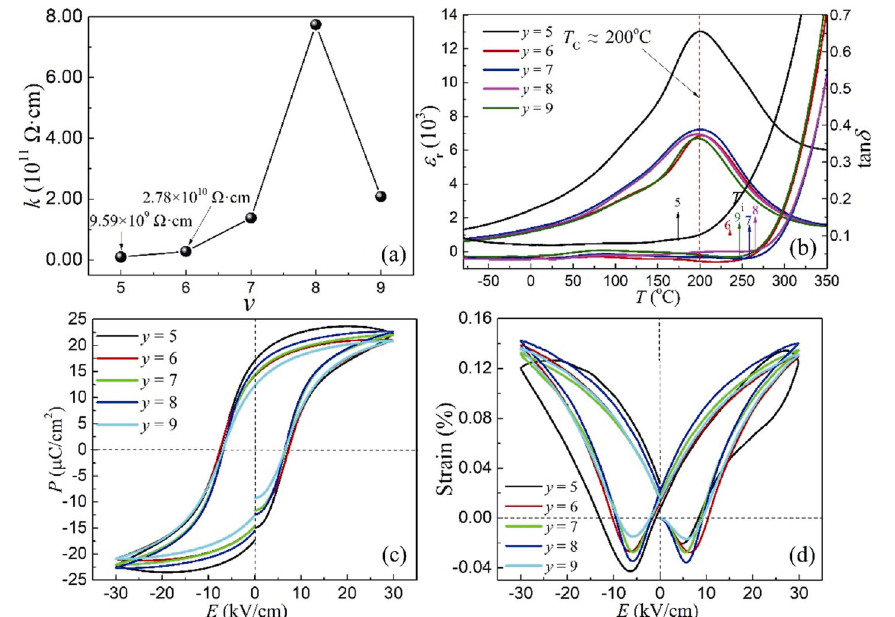
Fig. 5 (a) k of KNNT–0.055BZ + 0.03Zr + y Mn ceramics. (b) ε r and tan δ measured at 1 kHz for KNNT–0.055BZ + 0.03Zr + y Mn ceramics at the temperature range of (–80)–350 ℃ . (c) P – E loop and (d) S – E curves of KNNT–0.055BZ + 0.03Zr + y Mn ceramics at the frequency of 1 Hz under 30